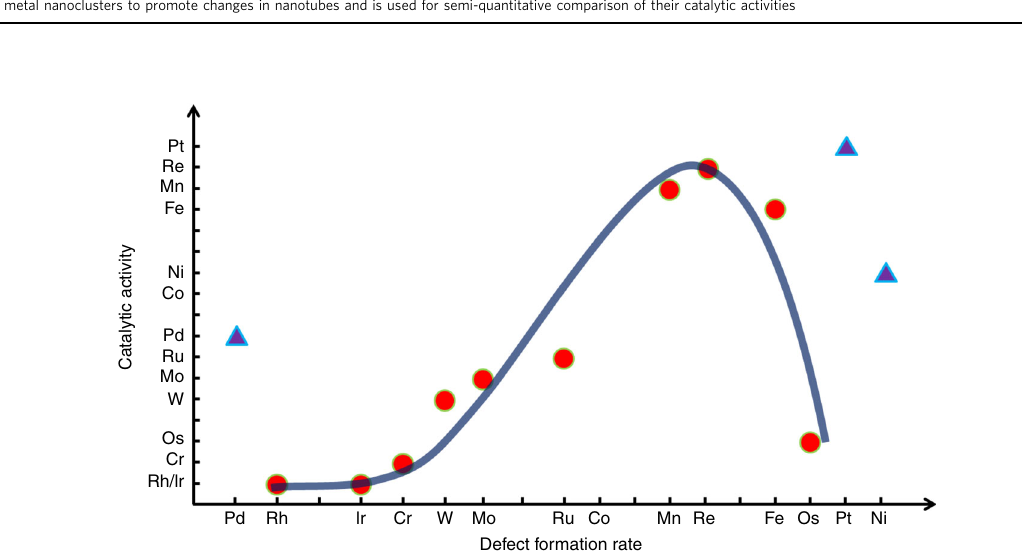
Fig. 5 Comparison of 14 transition metals. The level of catalytic activity observed for metal nanoclusters by ChemTEM imaging at 80 keV (series 2 in text) plotted against the rate of defect formation in nanotubes promoted by metal nanoclusters (series 1 in text, linked to nanocluster-carbon bonding) under the same conditions, providing a qualitative link between the two trends. A clear volcano-shape correlation is observed re fl ecting the Sabatier principle of heterogeneous catalysis for all metals, except those of group 10 (Ni, Pd and